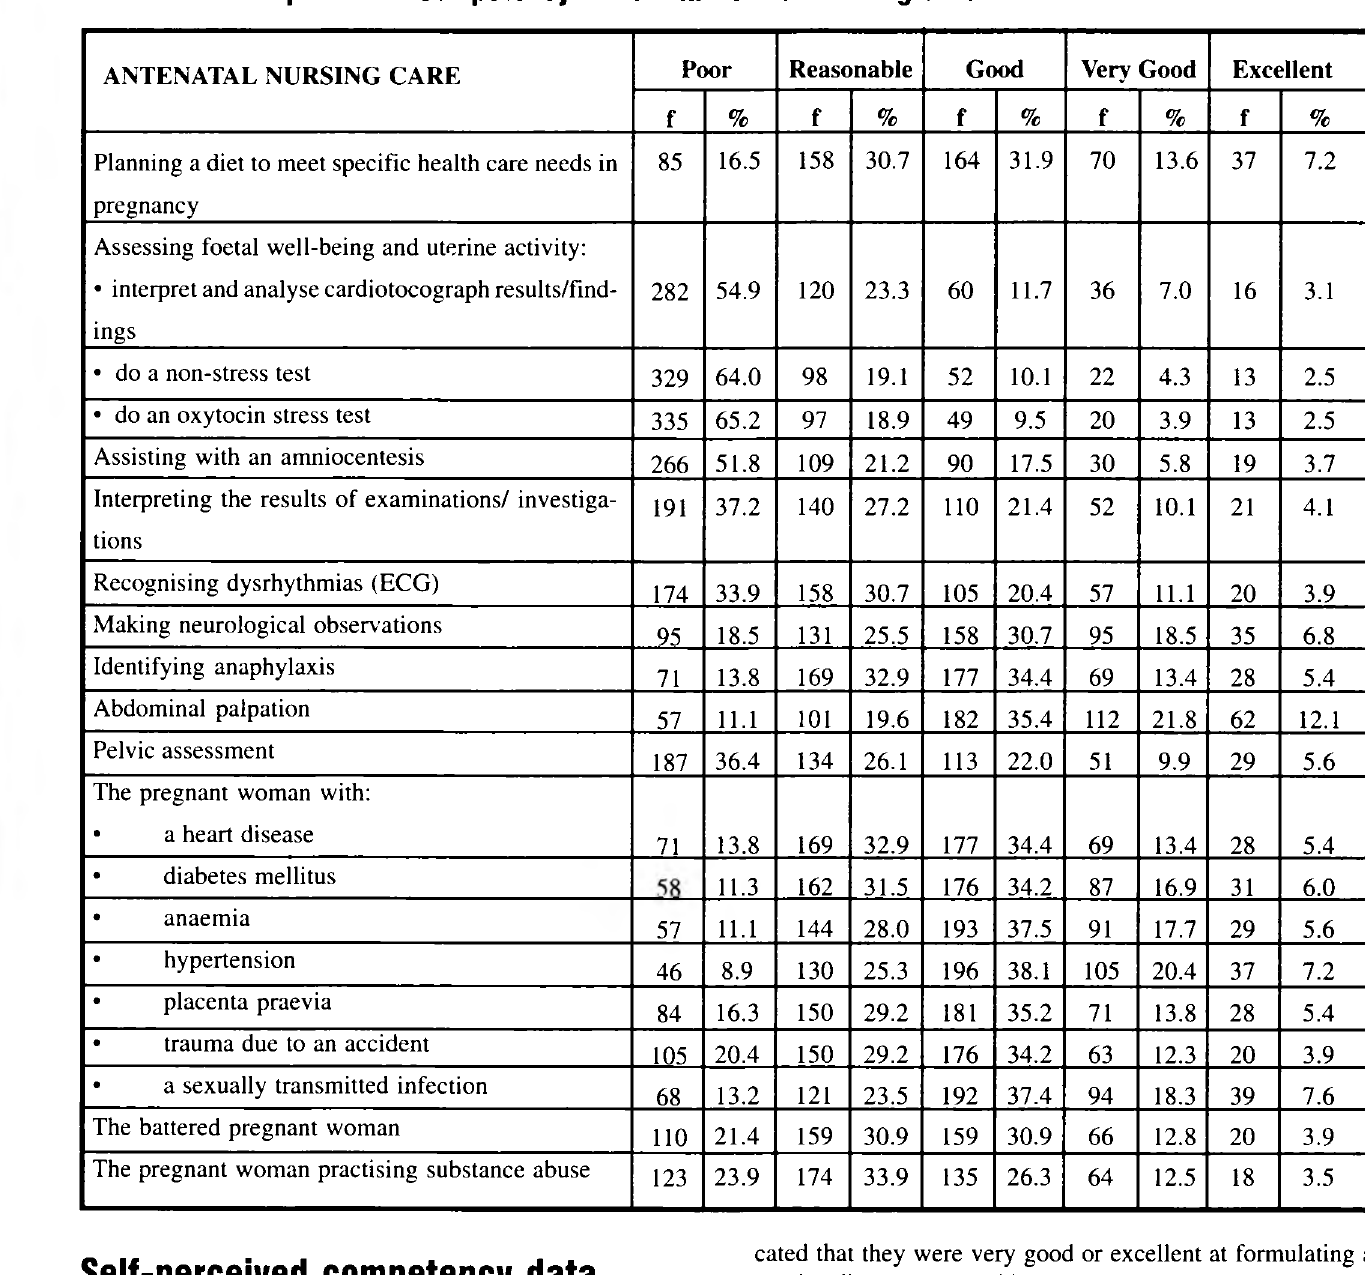
Self-perceived competency: antenatal related nursing care ANTENATAL NURSING CARE